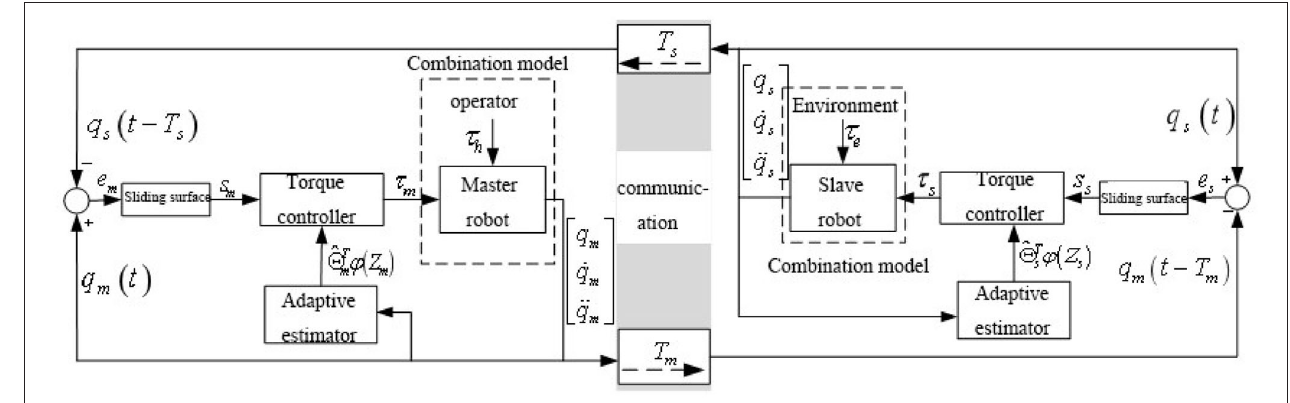
FIGURE 1 | A control structure diagram of time delay force feedback teleoperation system with finite time